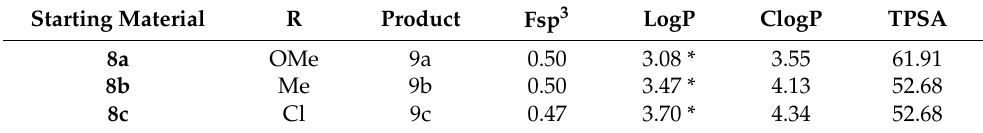
Table 1. The physicochemical parameters of the hydrazone derivatives ( 8a–c and 9a–c ). Starting